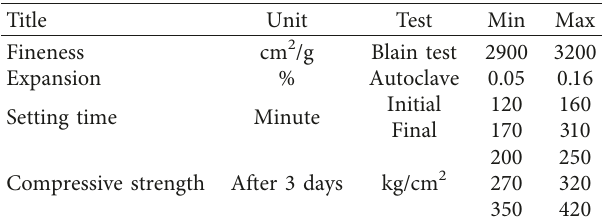
Figure 1: Location of the case study. Larestan is a city in the south part of Iran and is the largest city in Fars province [18]. Table 1: The physical properties of used cement: the most com- monly available cement in Larestan (Hormozgan type II Portland cement).